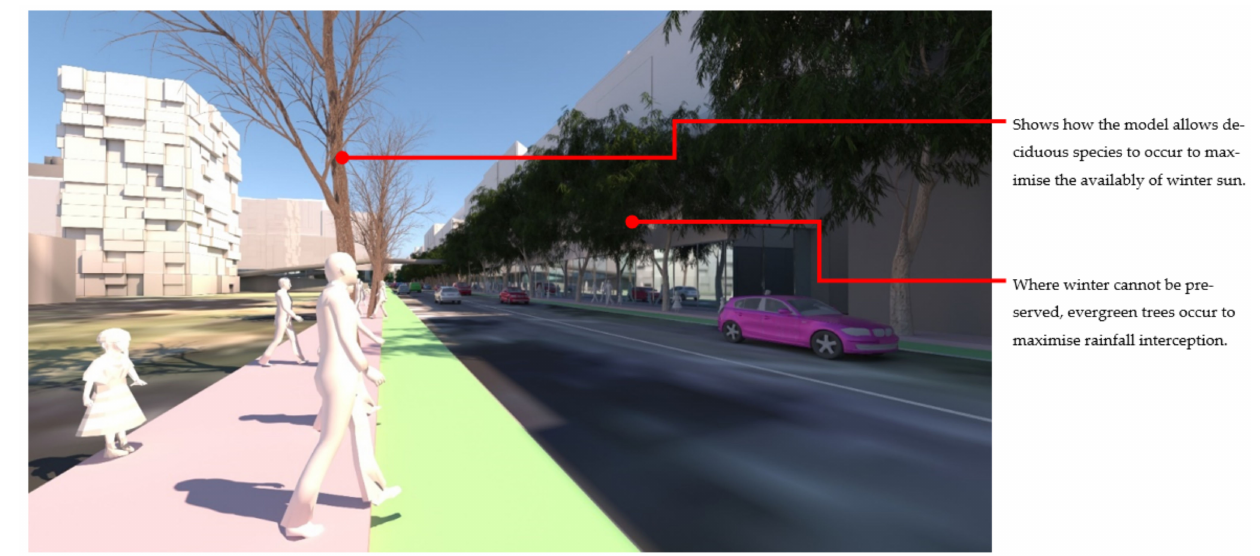
Figure 21. Image shows a winter view of Macaulay Road. On the righthand side the evergreen trees ( Angophora costata ) occur in the (dry/overshadowed condition), and on the left-hand side, where winter solar access to the footpath can be preserved, deciduous species occur (wet or dry tolerant depending on the flood scenario). Image by authors using multi-criteria street tree design decision